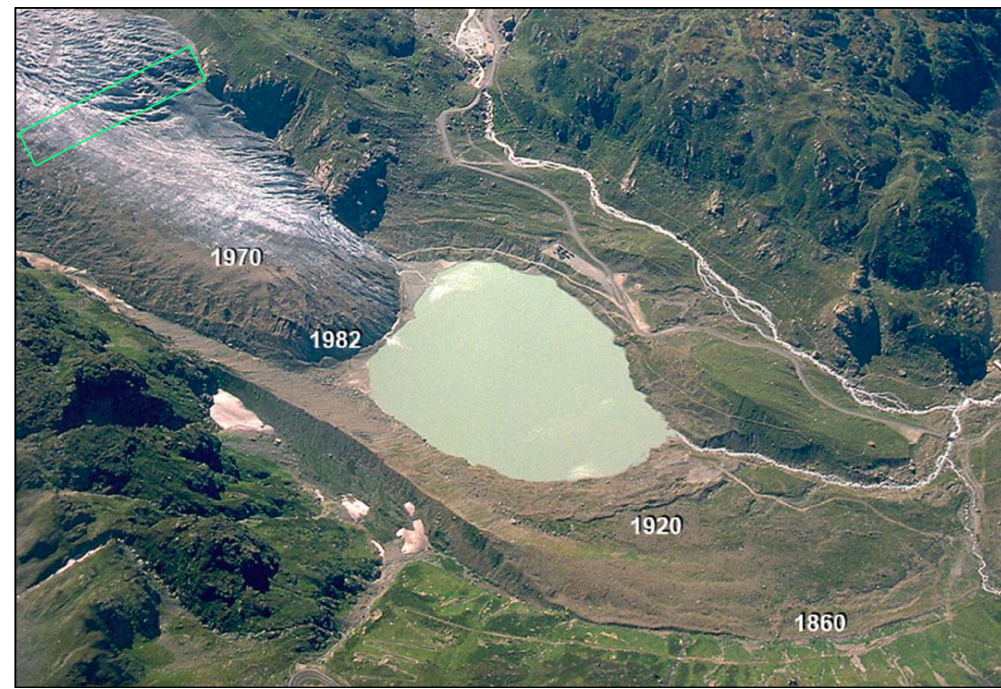
Figure 4. Aerial photograph of Steingletscher terminus position in 1982CE with indications of the timing of earlier glacier extents, from http://www.swisseduc.ch (last access: 10 January 2022). The location of the Chüebergli sample profile is indicated by the green box. Ice thickness in 1982CE is estimated at ∼ 50 to ∼ 20m above the analyzed